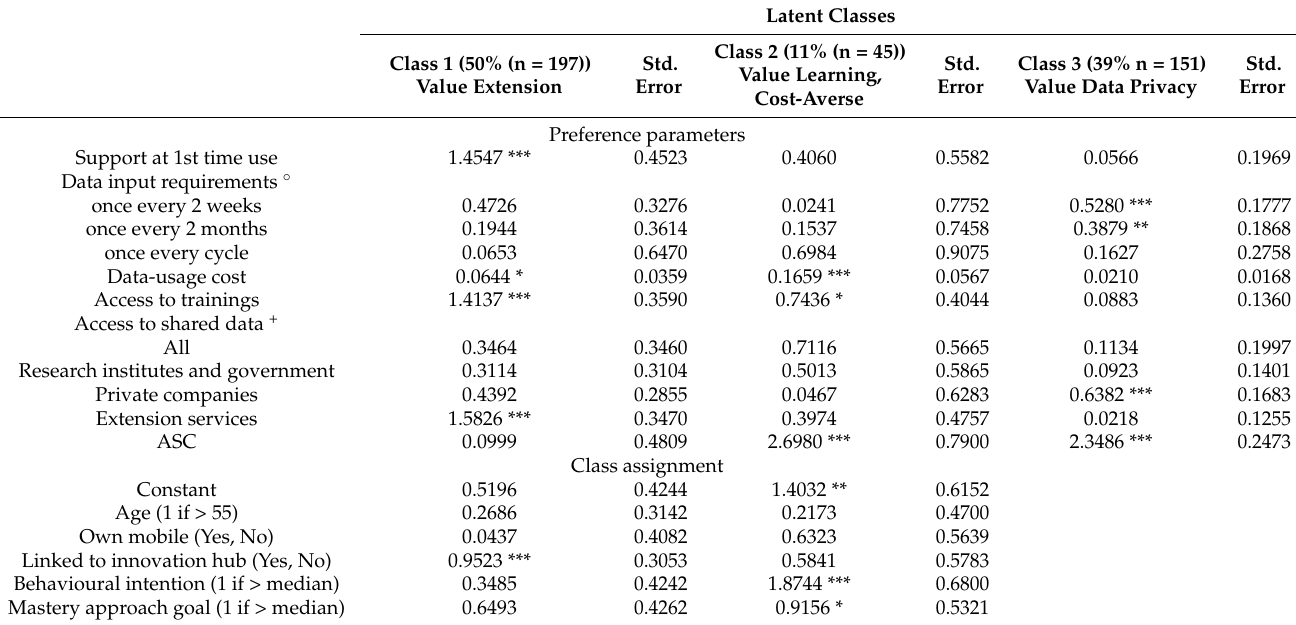
Table 4. Regression results (estimates) of the latent class model with 3 classes.